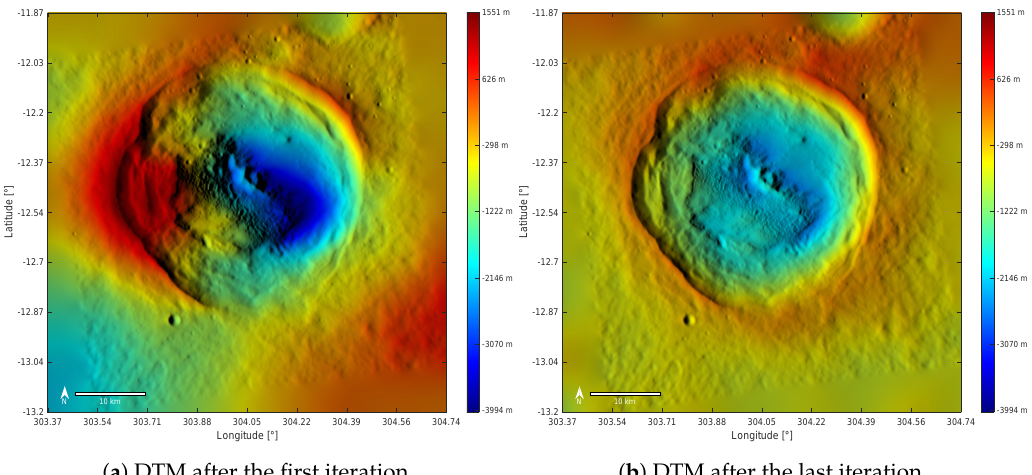
Figure 4. ( a ) Reconstruction without albedo initialization leads to unrealistic deviations in height left and right of the central peak. ( b ) The color-coded SfS DTM after the fourth iteration shows a more realistic surface.